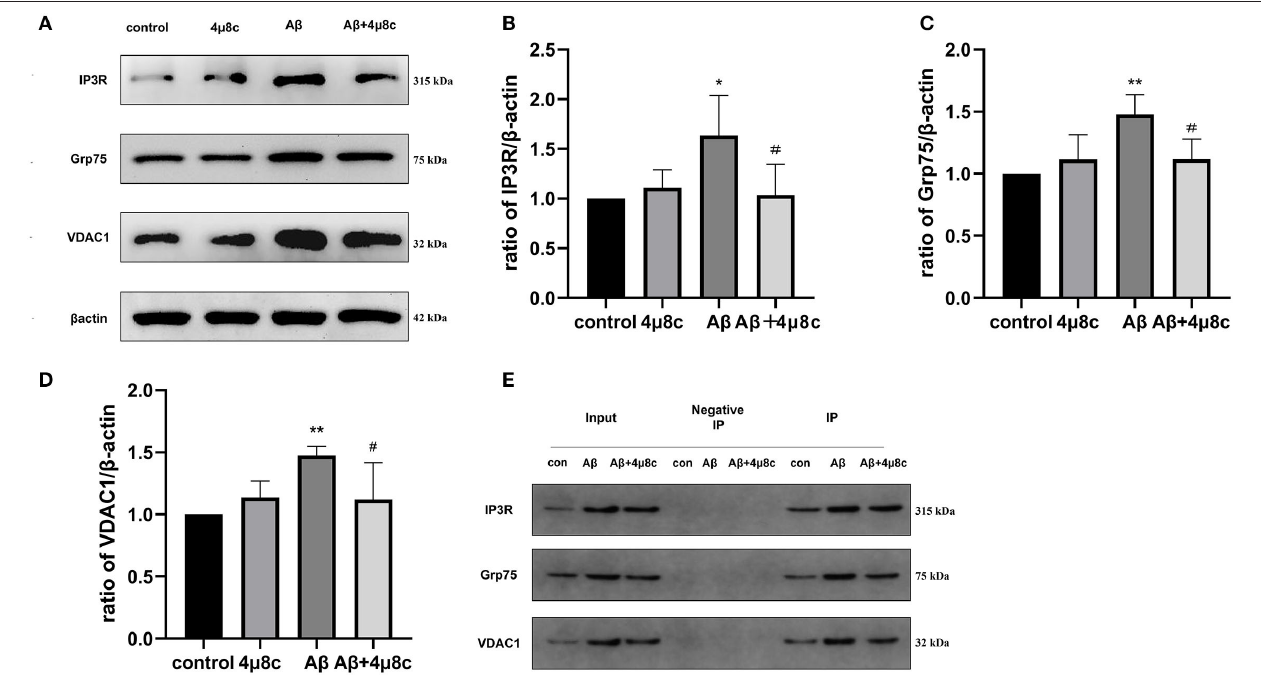
FIGURE 6 | The effect of IRE1 α -XBP1 on the IP3R-Grp75-VDAC1 complex in A β -treated cells. Cells were pretreated with or without 20 µ M 4 µ 8c for 6h, followed by treatment with 20 µ M A β 25–35 for 24h. (A) Western blot analysis of IP3R, Grp75, and VDAC1 proteins. (B–D) Densitometric analysis of the protein levels of IP3R, Grp75, and VDAC1 normalized to the level of β -actin. (E) Co-immunoprecipitation (Co-IP) was performed to analyze the IP3R-Grp75-VDAC1 interaction. Normal rabbit IgG without antigenicity was used as a negative control. Lysates from cells in each group without immunoprecipitation were used as a positive control (input). The proteins pulled down by anti-IP3Rantibodies were analyzed by Western blotting. The data are presented as mean ± SD ( n = 3), * p < 0.05 compared with the control. ** p < 0.01 compared with the control. # P < 0.05 compared with the A β 25–35-alone